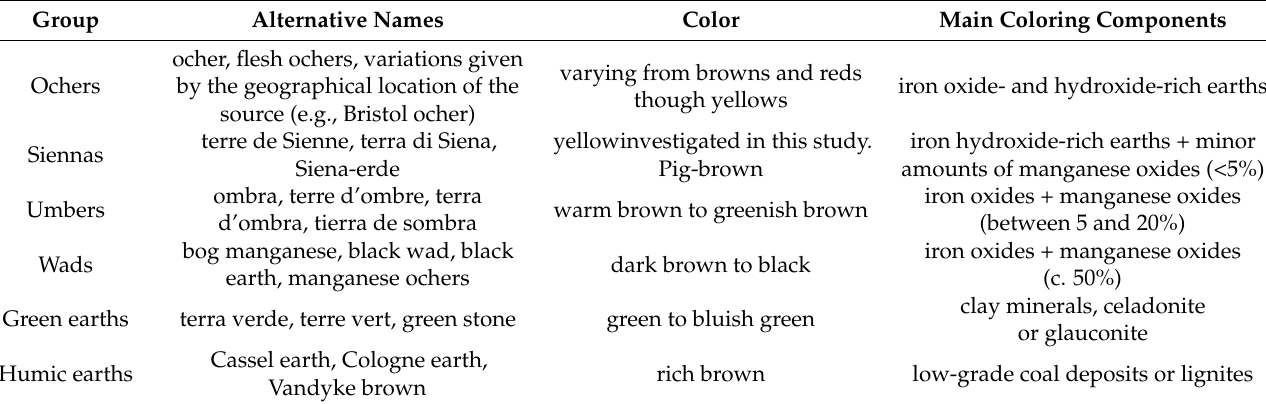
Table 1. The main groups of earth pigments and their principal characteristics